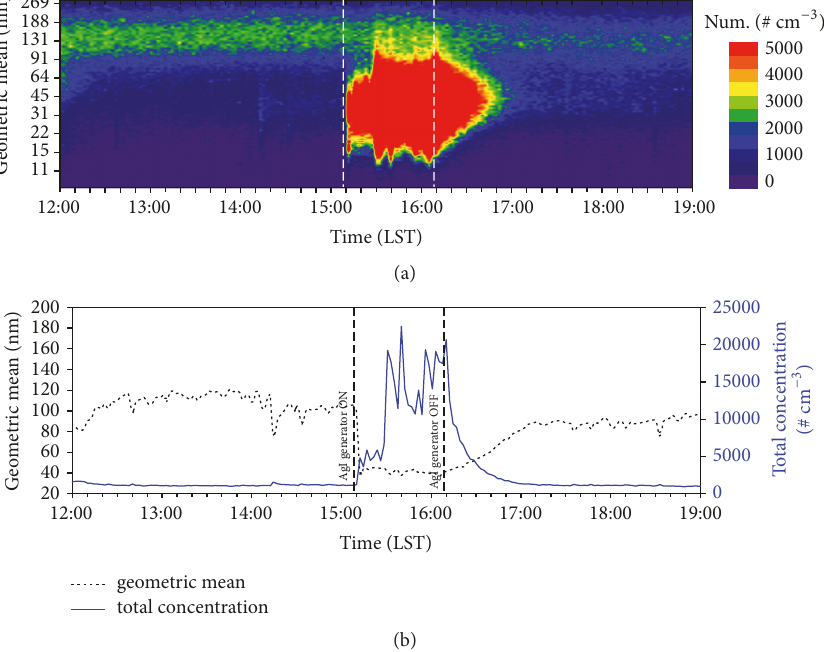
Figure 5: Distribution of the (a) particle number concentrations with geometric size and (b) time series of the geometric mean (dotted) and total particle number concentrations (solid) of aerosols measured by SNPS at CPOS on 7 Apr. 2015. The dashed lines represent the seeding